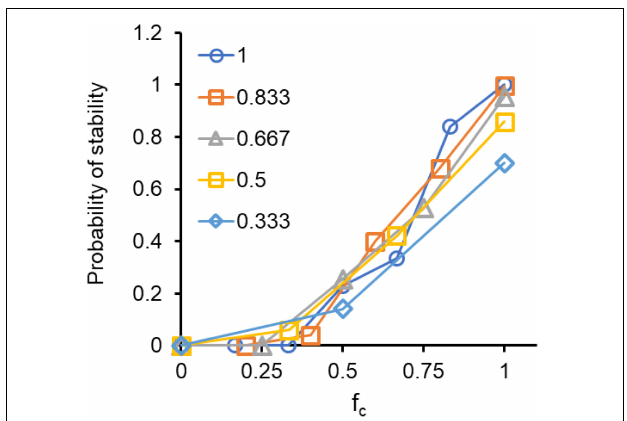
FIGURE 4 | Synergistic interactions make the system more stable. Randomized networks, when perturbed from their steady state have a greater tendency to return to the original steady state when the fraction of interactions which are cooperative is high. Perturbations were introduced such that frequency of each species changes by at least 20%. There exists a critical threshold of fraction of interactions, which should be positive for system to exhibit